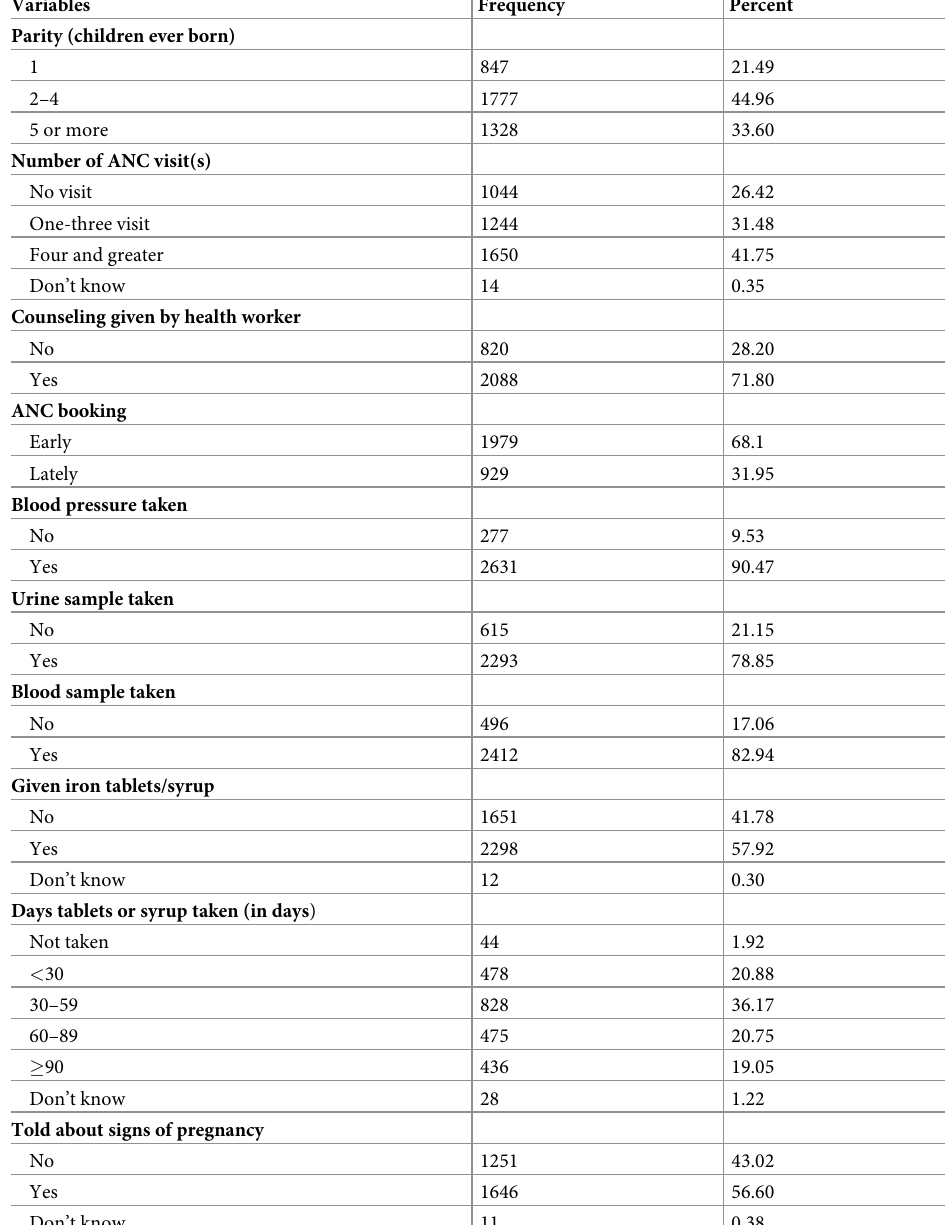
Table 2. Antenatal care service utilization and obstetric characteristics of women in Ethiopia (n = 3952).